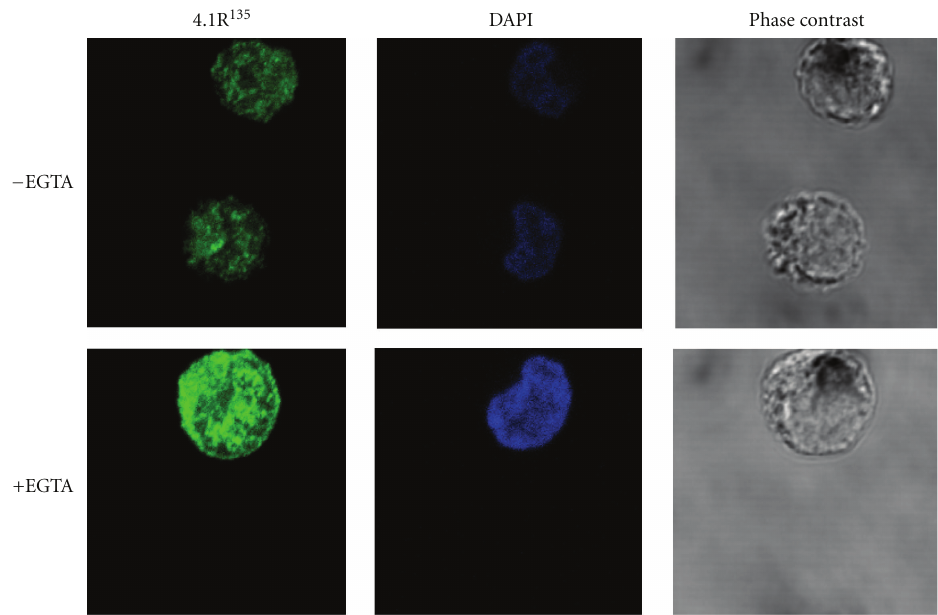
Figure 7: E ff ect of EGTA on the distribution of 4.1R 135 in human erythroblasts (cultured for 7 days). Human erythroblasts were cultured in the presence or absence of 1mM EGTA and immunostained with a rabbit antibody to RHP as previously described